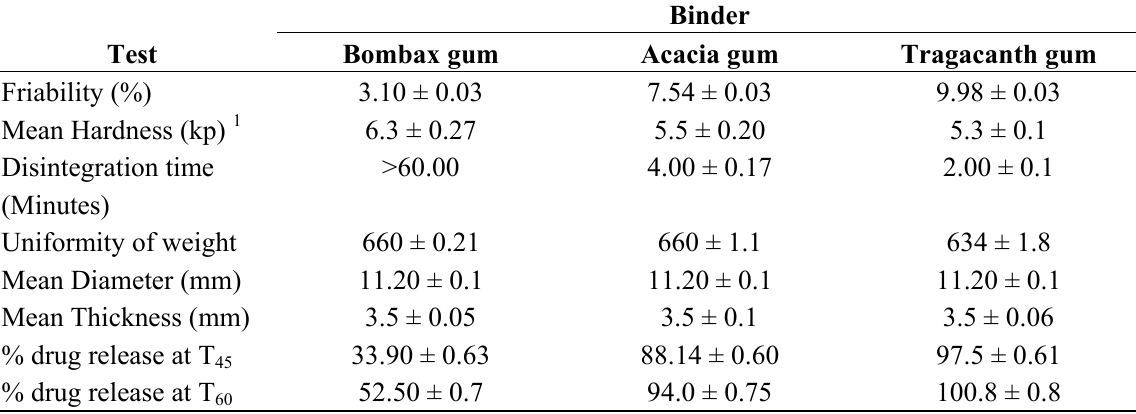
Table 2. Evaluation of tablets based on compendial and non-compendial